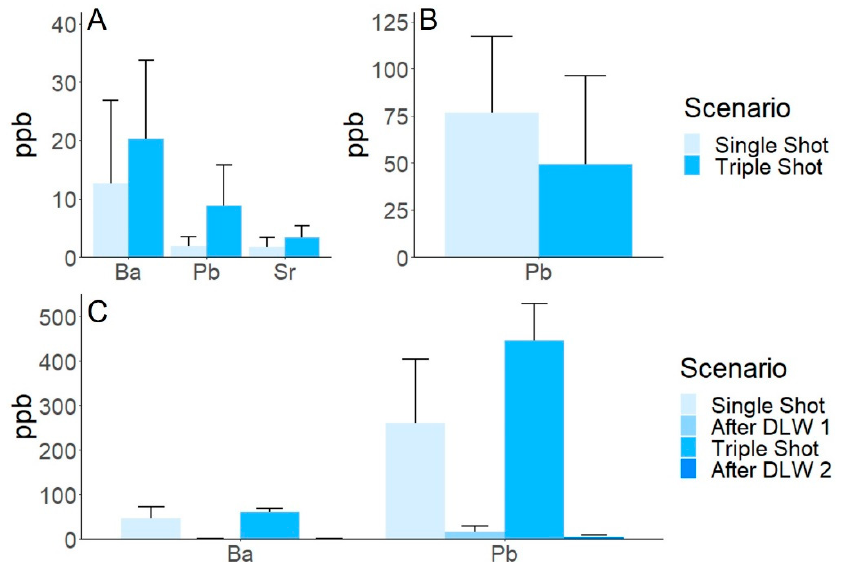
Figure 5. Elemental Concentrations. The elemental concentrations (ppb ± SEM) are shown for Ba, Pb, and Sr in filter samples ( A ), Pb in DST samples ( B ), and Ba and Pb in hand swab samples ( C ). Statistical significance was determined using a Welch’s t -test for comparison of single and triple shot scenarios (filter and DST) and a one-way ANOVA for multiple group comparisons (hand swabs) with a p -value of ≤ 0.05 considered significant. No statistically significant differences were observed.